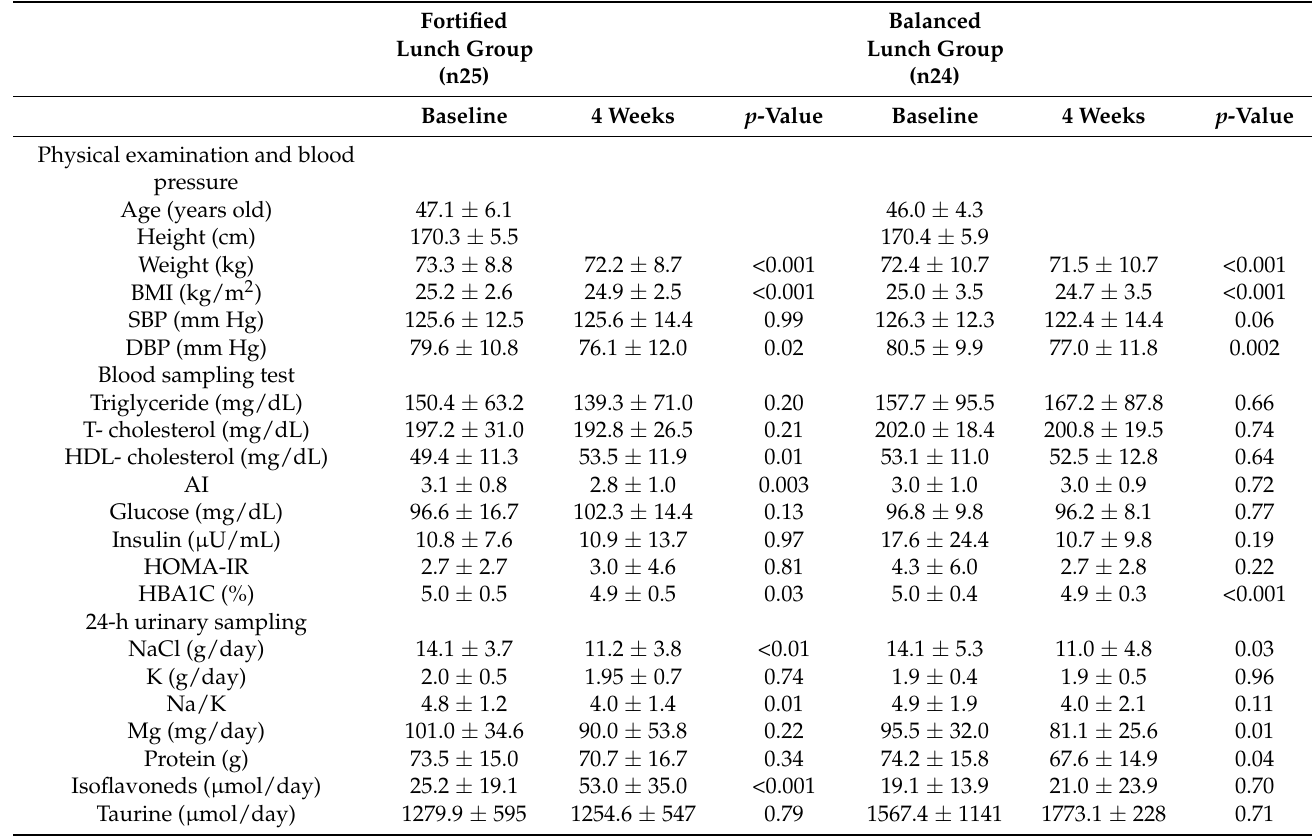
Table 3. Changes from the baseline data after 4-week intakes of Fortified Lunch (FL) and Balanced Lunch